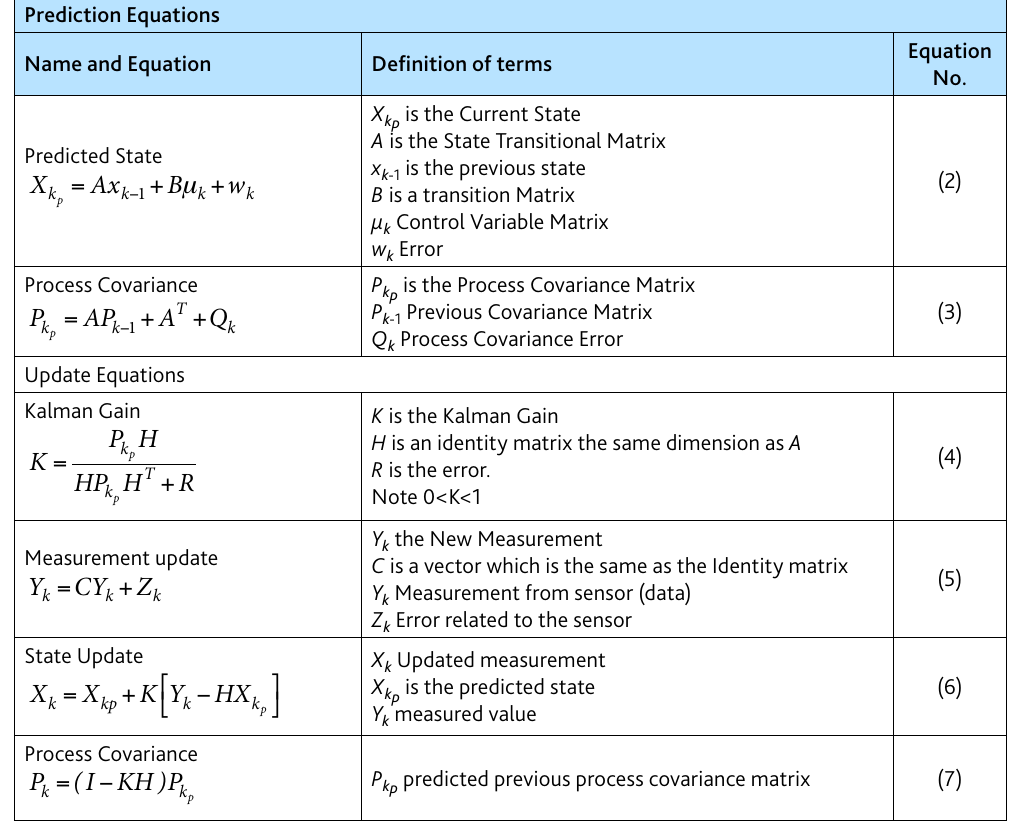
Table 2. Kalman Filter Equations